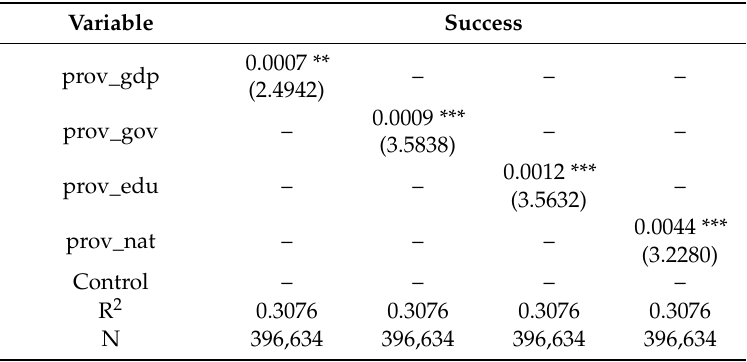
Table 6. Empirical analysis of the causes of regional discrimination (perspective of